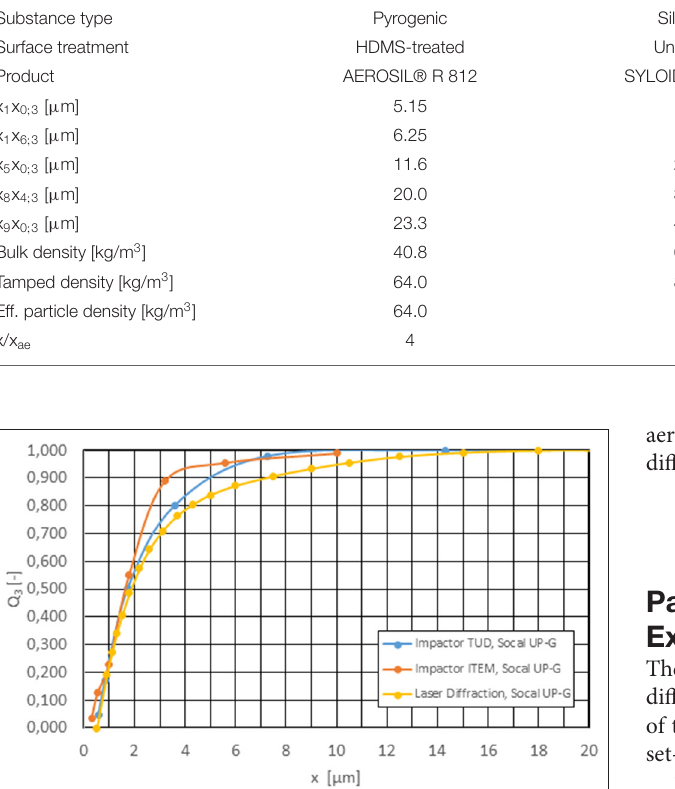
TABLE 2 | Products investigated, PSD at the aerosol generator, bulk and tamped density of powders. Substance